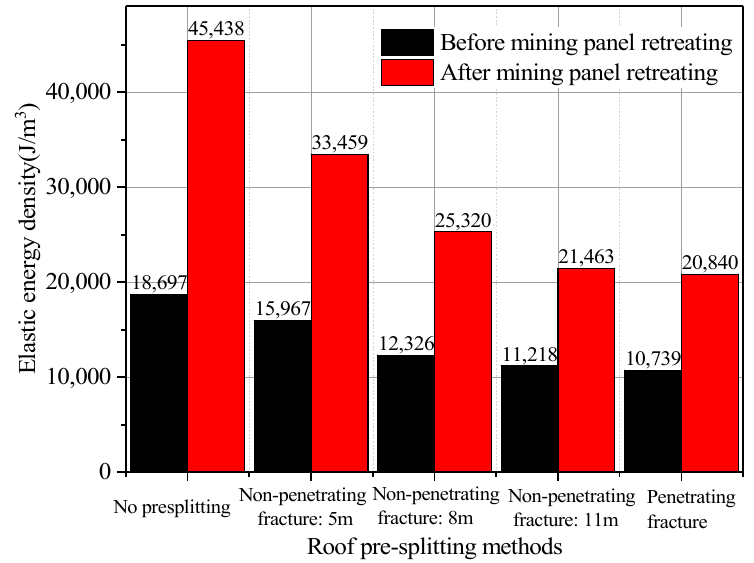
Figure 16. Maximum released elastic strain energy density of the coal pillar.